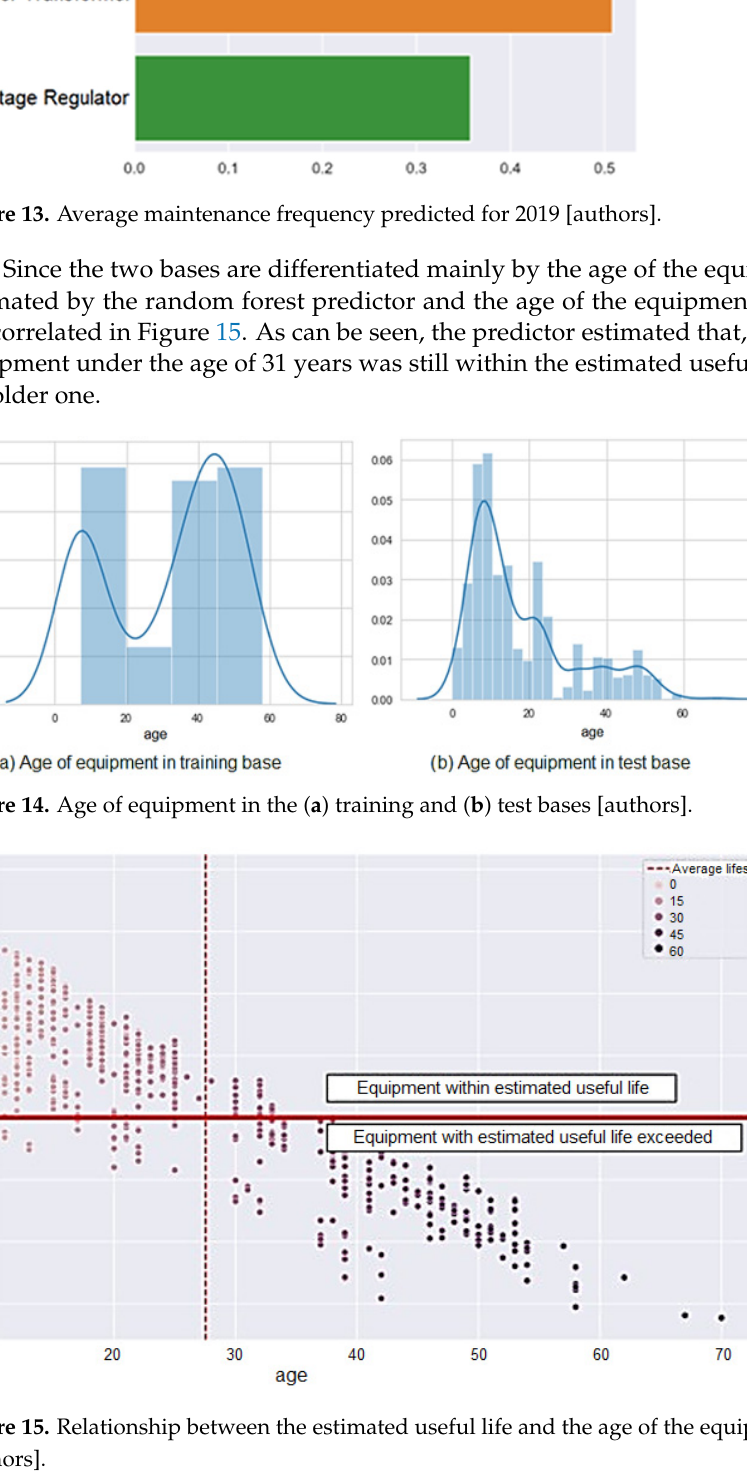
Figure 15. Relationship between the estimated useful life and the age of the equipment for RUT 210 [authors].